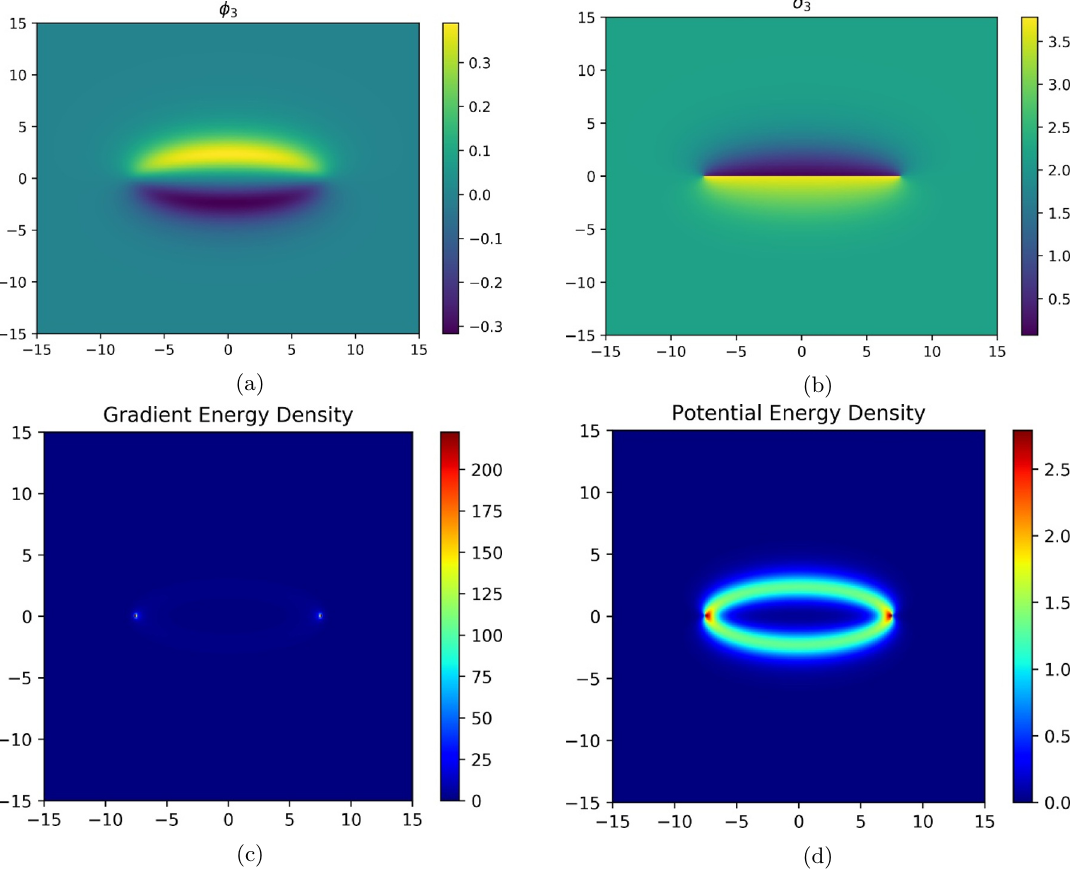
Figure 5. A typical example of a double-string solution for N = 5 . All the parameters are the same as those given in the caption of figure 3. Note that there are N − 1 = 4 field components, each with real and imaginary parts. Only the (a) real and (b) imaginary parts of the third field are shown, though the rest are similar. Figure (c) and (d) are the first and second terms of the energy density in